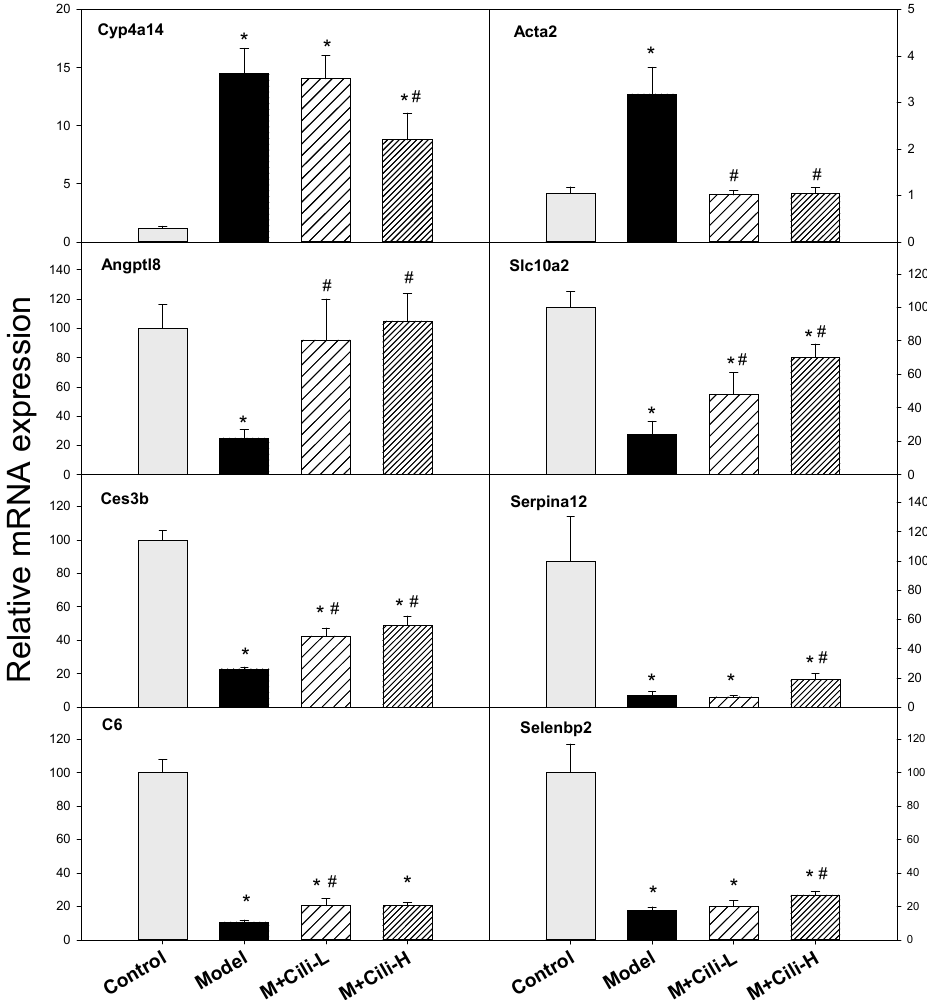
Figure 9. qPCR analysis gene expression related to lipid metabolism related genes among groups. Data are mean ± SEM ( n = 8), * Significantly different from the Control group, p < 0.05; # Significantly different from the Model group, p < 0.05.